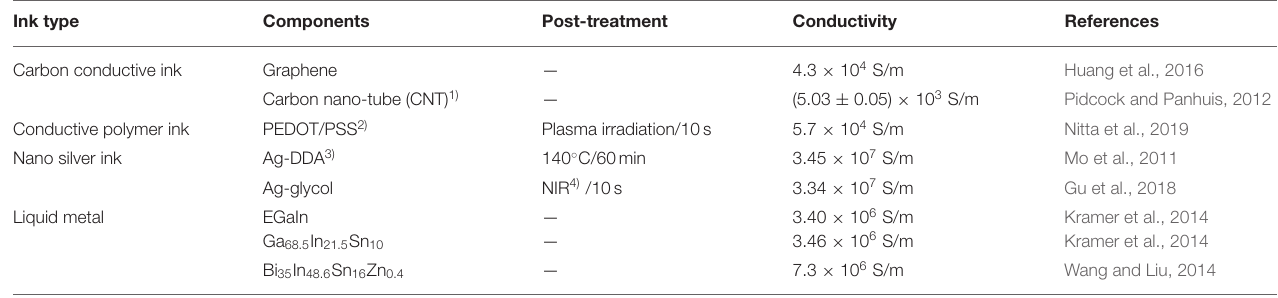
TABLE 2 | A comparison of the electrical conductivities of several typical conductive